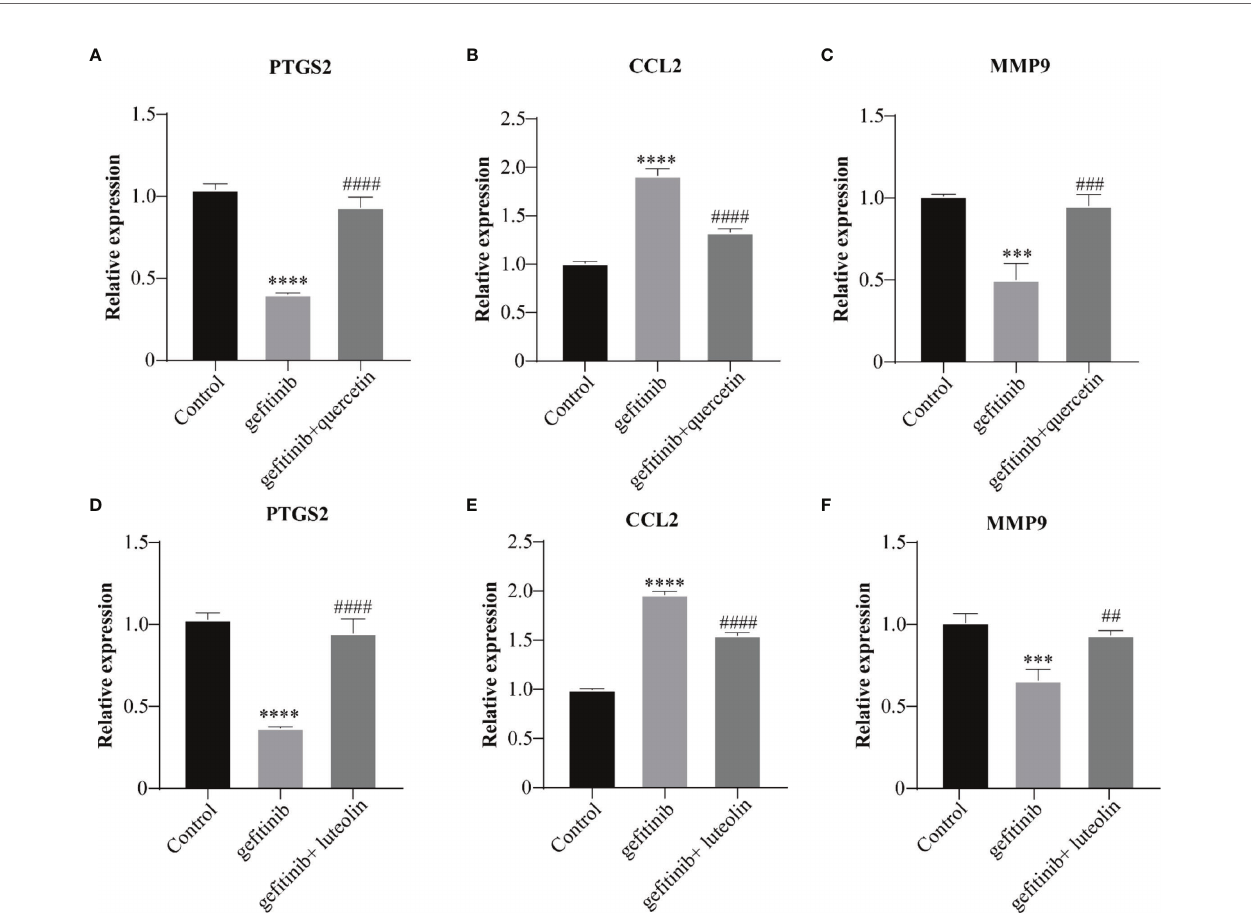
FIGURE 10 | QYSLS mitigated EGFRI-induced adverse skin reactions by regulating the IL-17 and TNF pathway. qPCR was used to detect the mRNA expression levels of PTGS2, CCL2, and MMP9 in mice treated with quercetin (A – C) and luteolin (D – F) . “ * ” compared with Control, ***p < 0.005, ****p < 0.0001. “ # ” compared with Ge fi tinib, ## p < 0.01, ### p < 0.005, #### p <